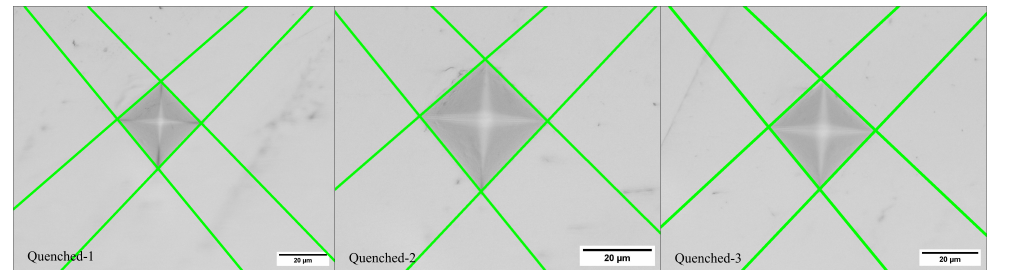
Figure A3. Corner detection on Steel samples at 5N applied force.